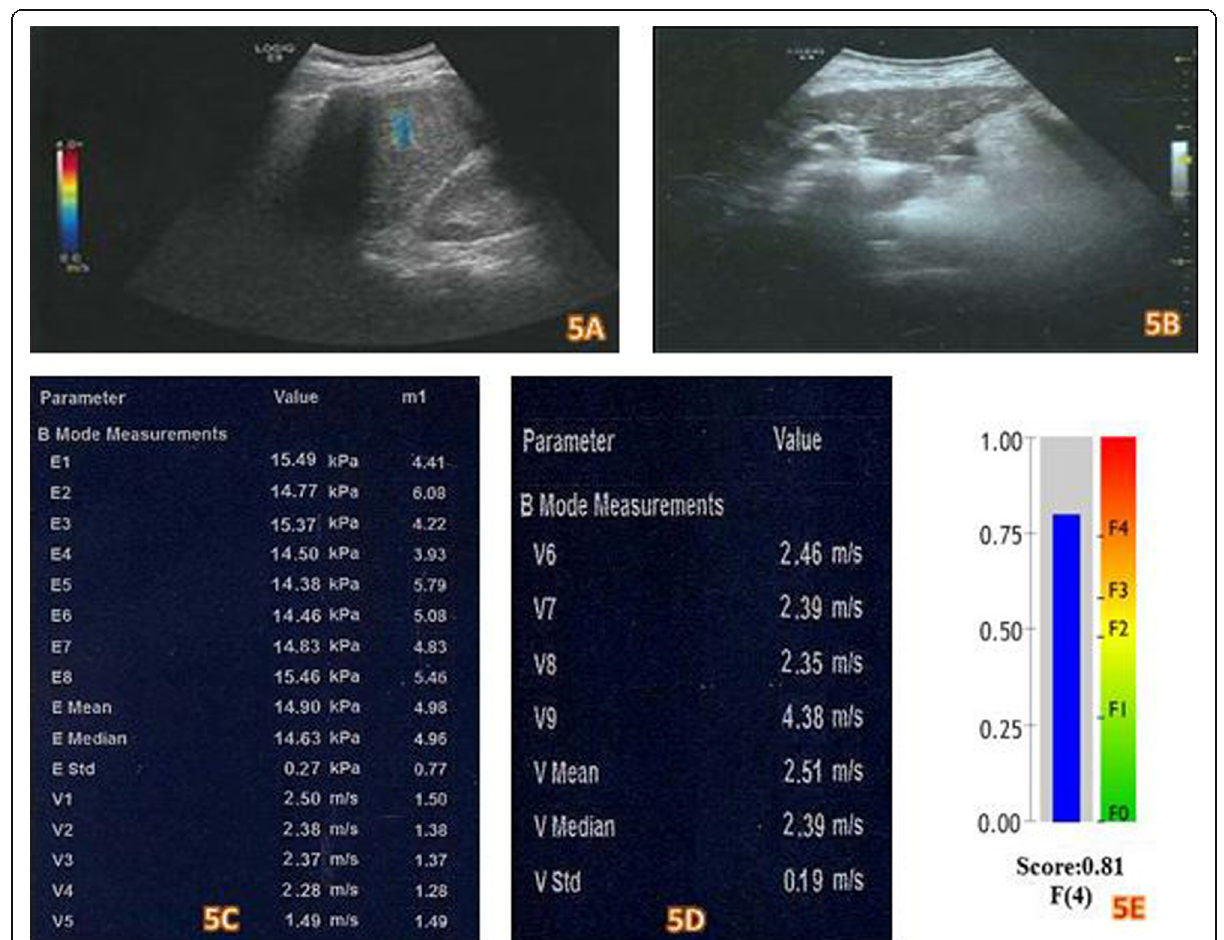
Fig. 5 F3-F4 stage: A female patient aged 64 years old with HCV chronic hepatitis and elevated AST and ALT. Conventional US reveals the following ( a and b ): Liver >>irregular nodular (score 3), coarse with reticular pattern (score 3), hepatic veins with irregular wall and normal caliber (score 2) “ cumulated score 8. ” Mild ascites, enlarged spleen size (longitudinal axis =178 mm), dilated portal vein caliber. 2D shear wave elastography ( c and d ): Velocity median value = 2.39 m/s. Stiffness median value =14.63 kPa. Fibrotest result was 0.81 denoting F4 stage ( e )